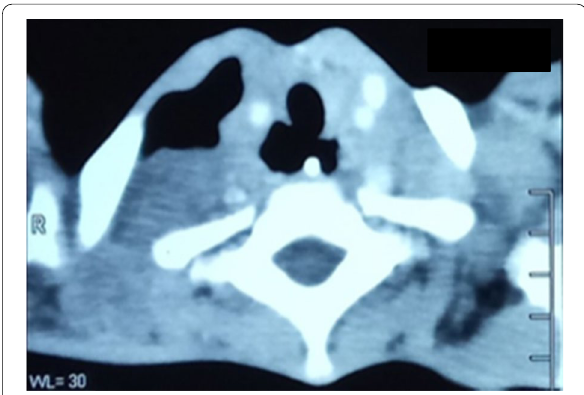
Fig. 1 Tracheoesophageal fistula after chemotherapy at C7 vertebra level with dimensions of 2.2 cm Fig. 3 Tracheoesophageal fistula at D2 vertebral